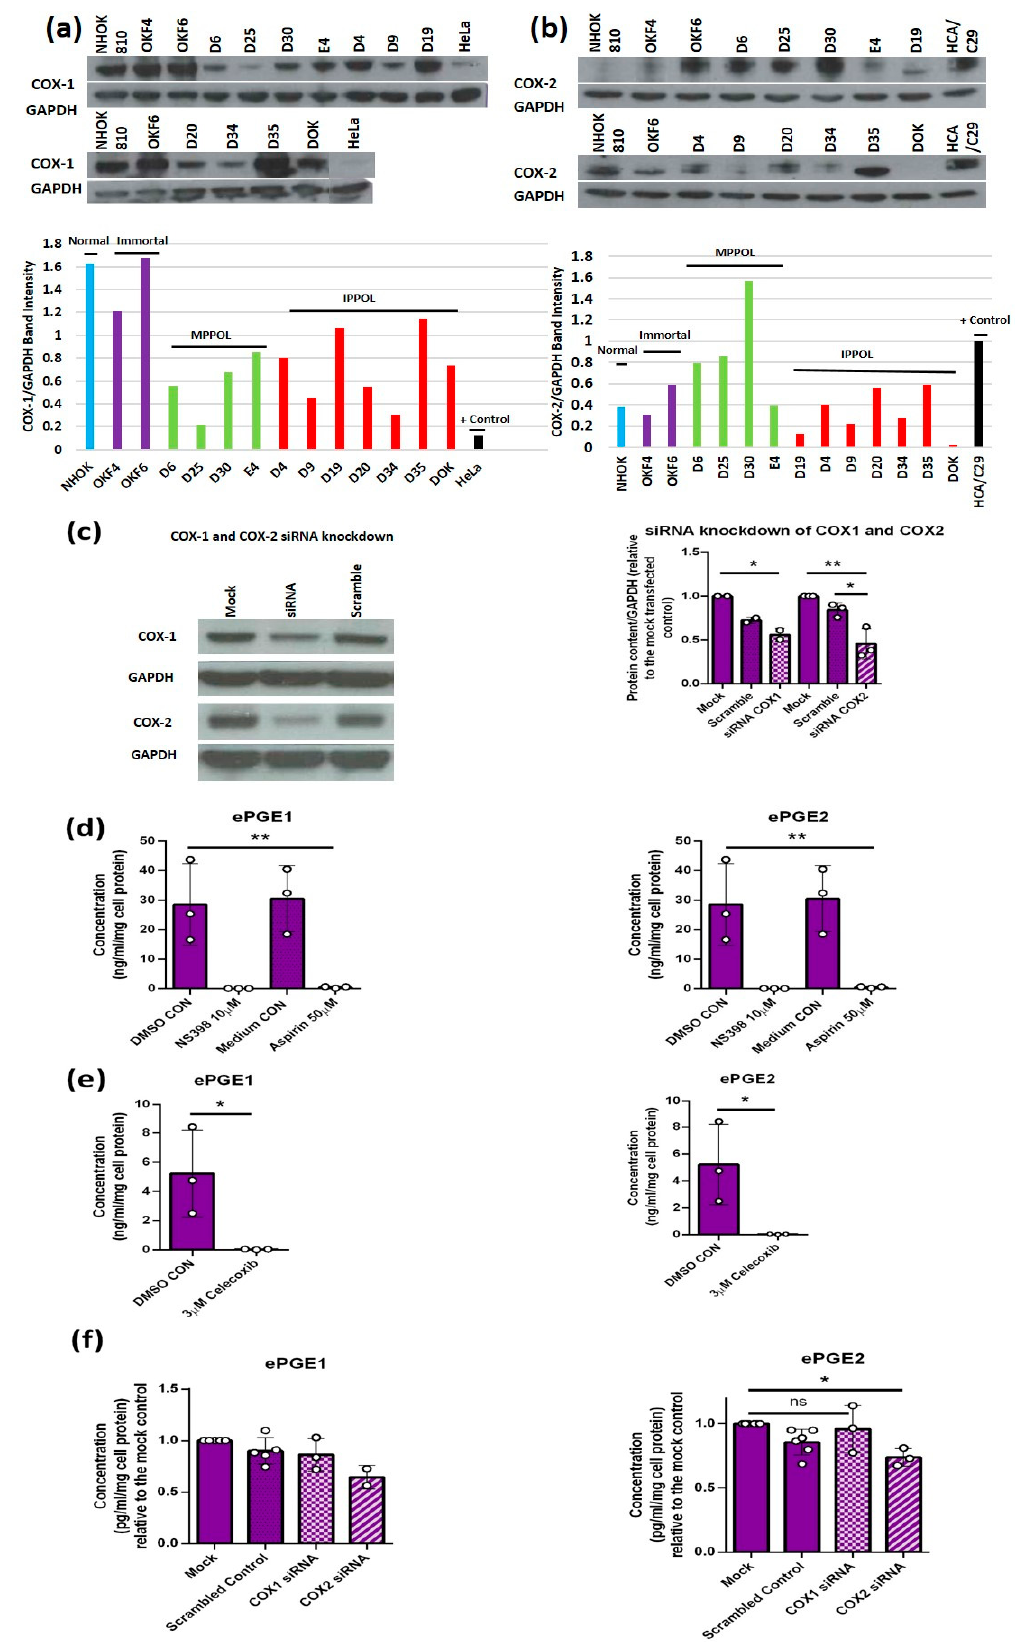
Figure 3. ePGE expression in MPPOL keratinocytes is mediated by COX-2. ( a ) Shows a Western blot (upper panel) and quantitation of the band intensity (lower panel) of COX-1 expression in the